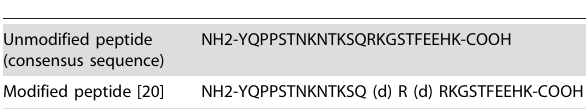
Table 2. MGF Peptide sequences.